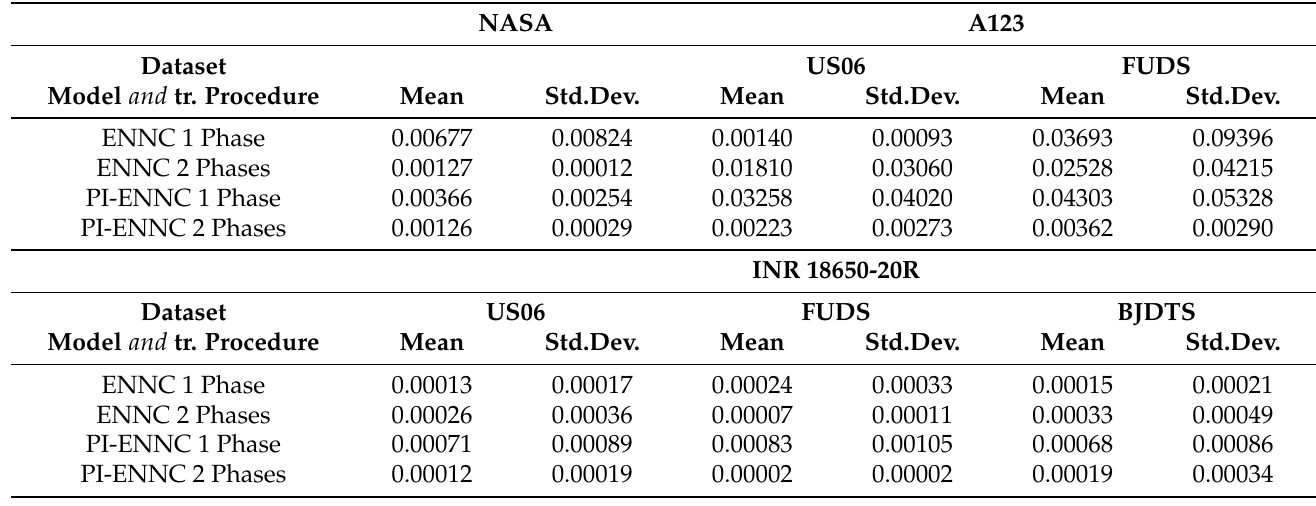
Table 5. Mean and standard deviation on SoC MSE prediction. Results are sorted per test sets, BMS model and training